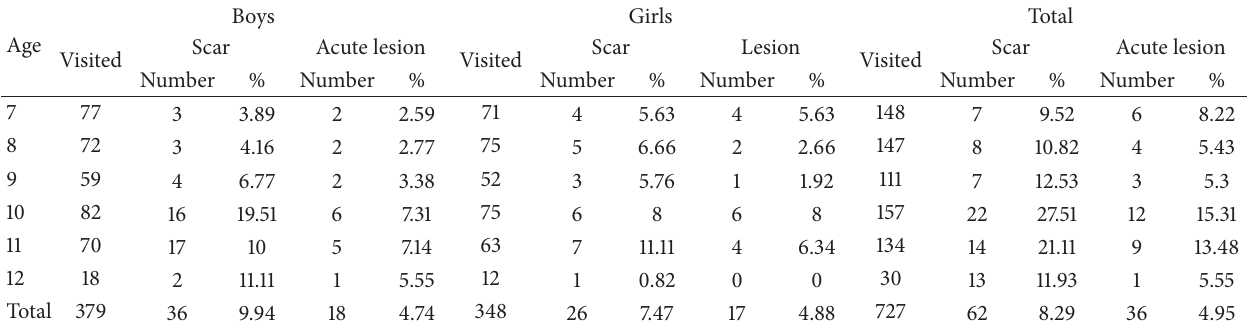
Table 2: Prevalence of acute lesion and scar in primary schools of the studied area, Khatam County, Yazd Province, central Iran, 2006. Boys Girls Total Age Scar Visited Visited Visited